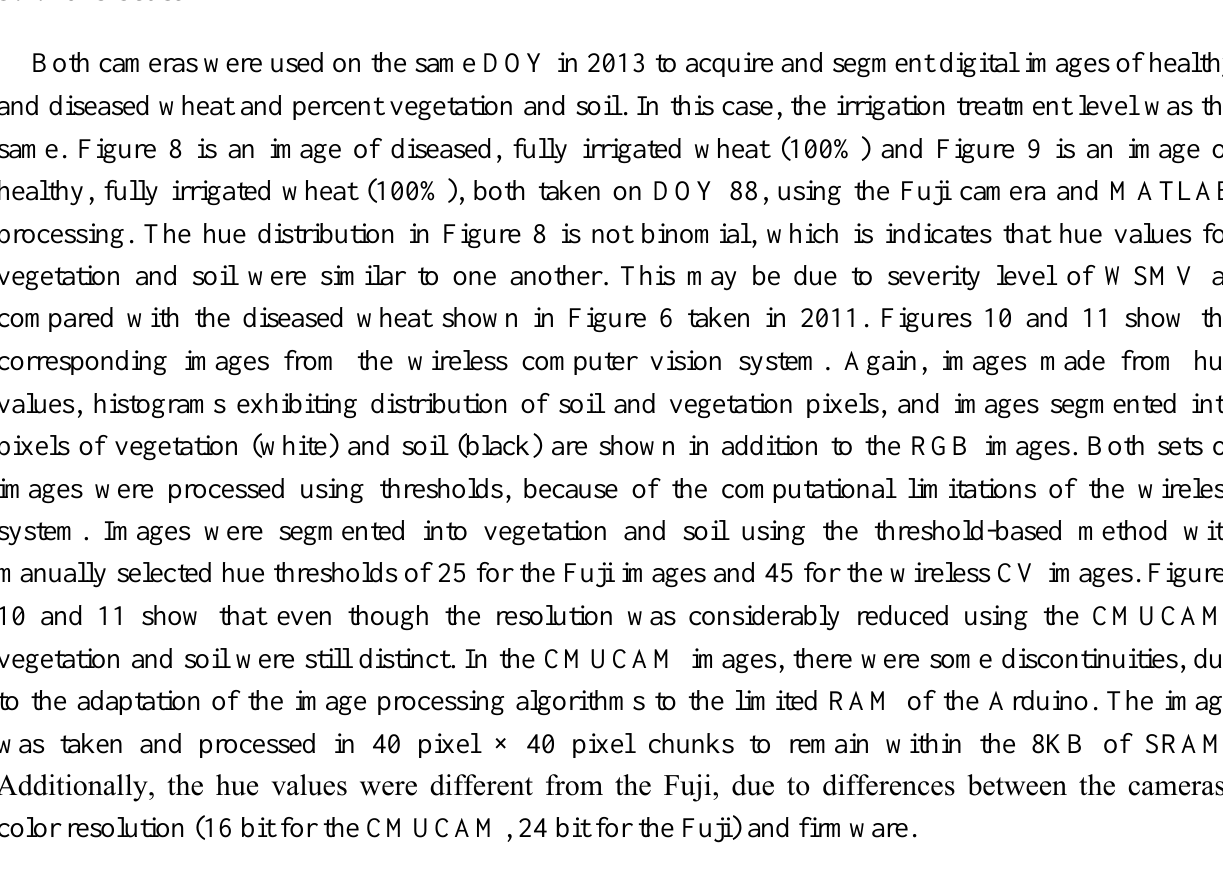
Figure 8. Example of Fuji image analysis for wheat, DOY 88, 2013, diseased, 100%. Axes on images are in pixels. Pixels classified as vegetation are shown in white (lower